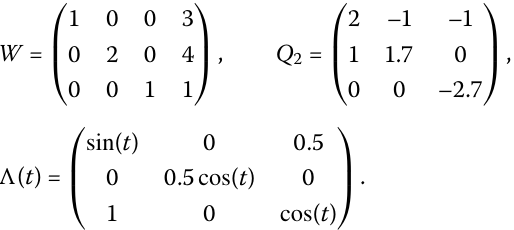
Figure 6 Time series of the synchronization error